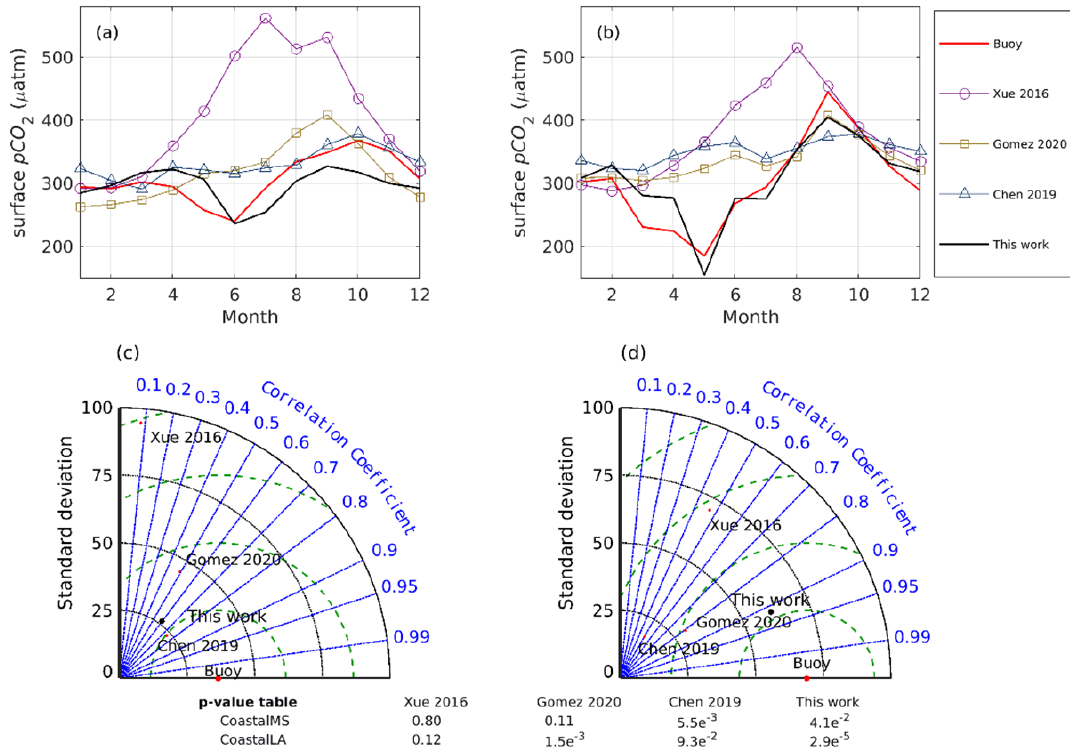
Figure 16. Comparison of sea surface p CO 2 among regional ocean model products (Xue 2016, Gomez 2020, Chen 2019, this work) at two buoy sites. Climatology at the two buoy locations of Gomez et al. (2020) is calculated by multiyear averaging from 2000–2014 model surface results. Climatology at the two buoy locations of Xue et al. (2016) is calculated by multiyear averaging from 2005–2010. Climatology at the two buoy locations of Chen et al. (2019) is calculated from their 12-monthly ML surface p CO 2 product (from July 2002 to December 2017). Buoy raw observations have a frequency of ∼ 3h, and monthly averages are used to be compared with monthly model estimates. The p value for each correlation coefficient is listed in the p -value table.